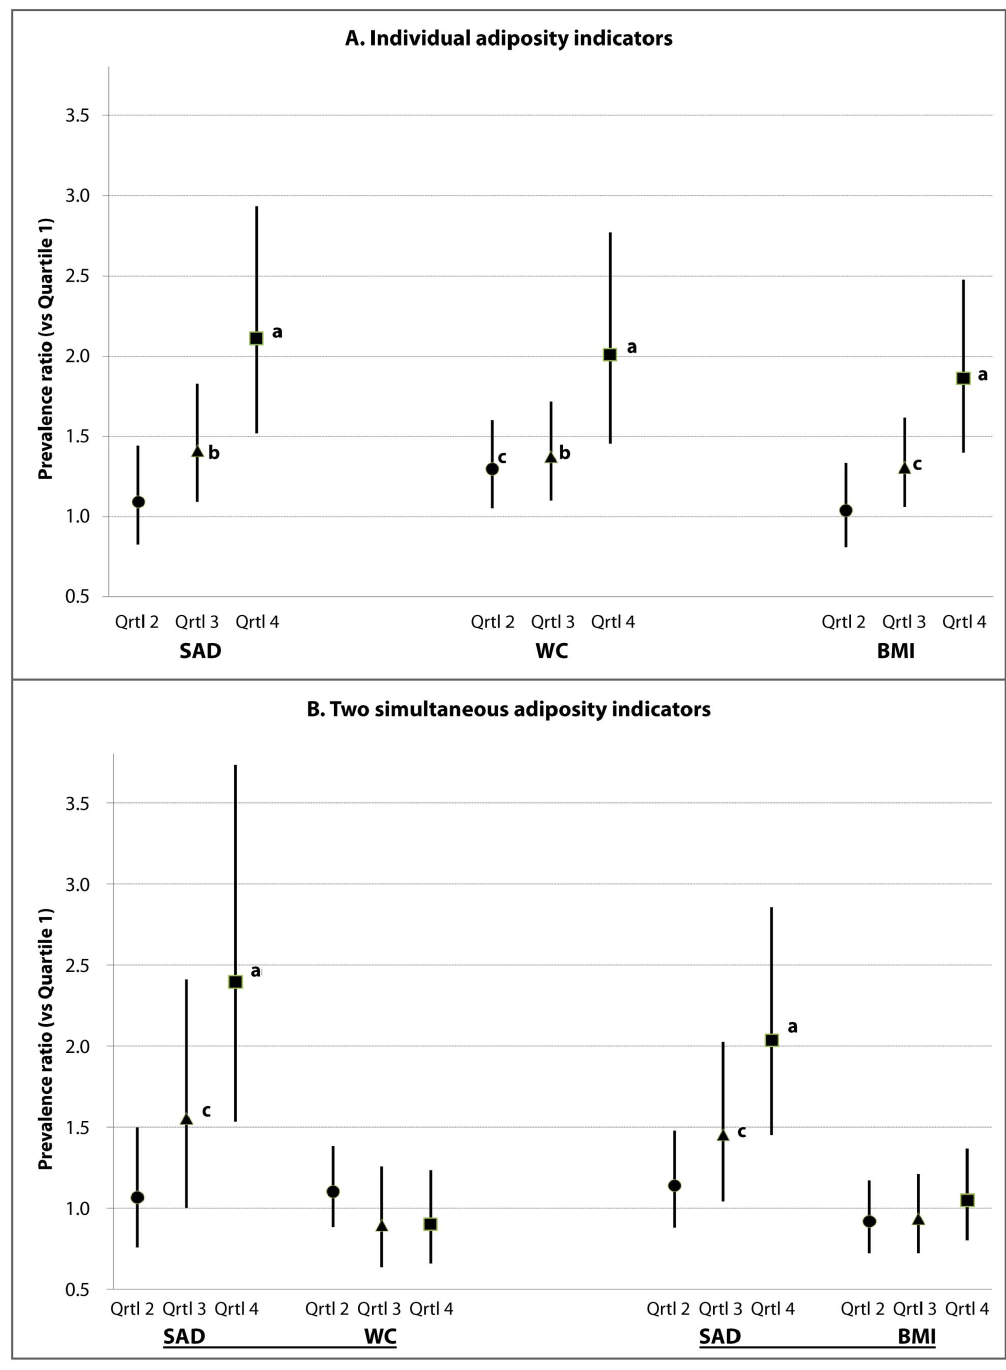
Figure 2. Panel A: Dysglycemia prevalence ratios by quartiles of sagittal abdominal diameter (SAD), waist circumference (WC) or body mass index (BMI). Panel B: Prevalence ratios when SAD is considered simultaneously with WC (left side) or with BMI (right side). In age-adjusted models, the relative prevalence of dysglycemia (HbA1c $ 5.7% [ $ 39 mmol/mol]) is displayed in association with the second (circle), third (triangle), and fourth (square) quartiles (with reference to first quartile) of each indicator. Error bars indicate 95% confidence intervals. a p , 0.001; b p , 0.01; c p , 0.05. doi:10.1371/journal.pone.0108707.g002 prevalence ratios (PRs) relative to the lowest quartile; each model’s goodness of fit was estimated as R 2 (Cox & Snell method). We examined ordinal quartiles for each adiposity indicator individu- ally, as well as the independent effect of SAD quartiles in models that also included either BMI quartiles or WC quartiles.